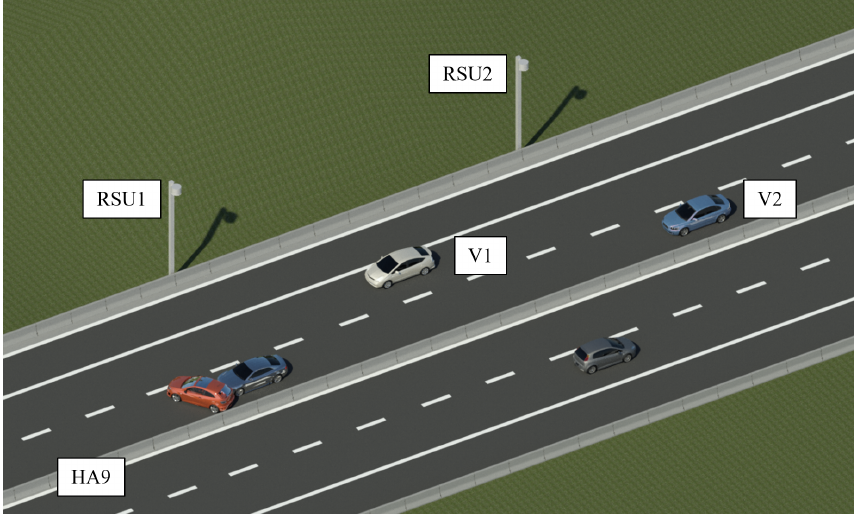
Figure 8. Visualization of the BIM model of the ITS simulation